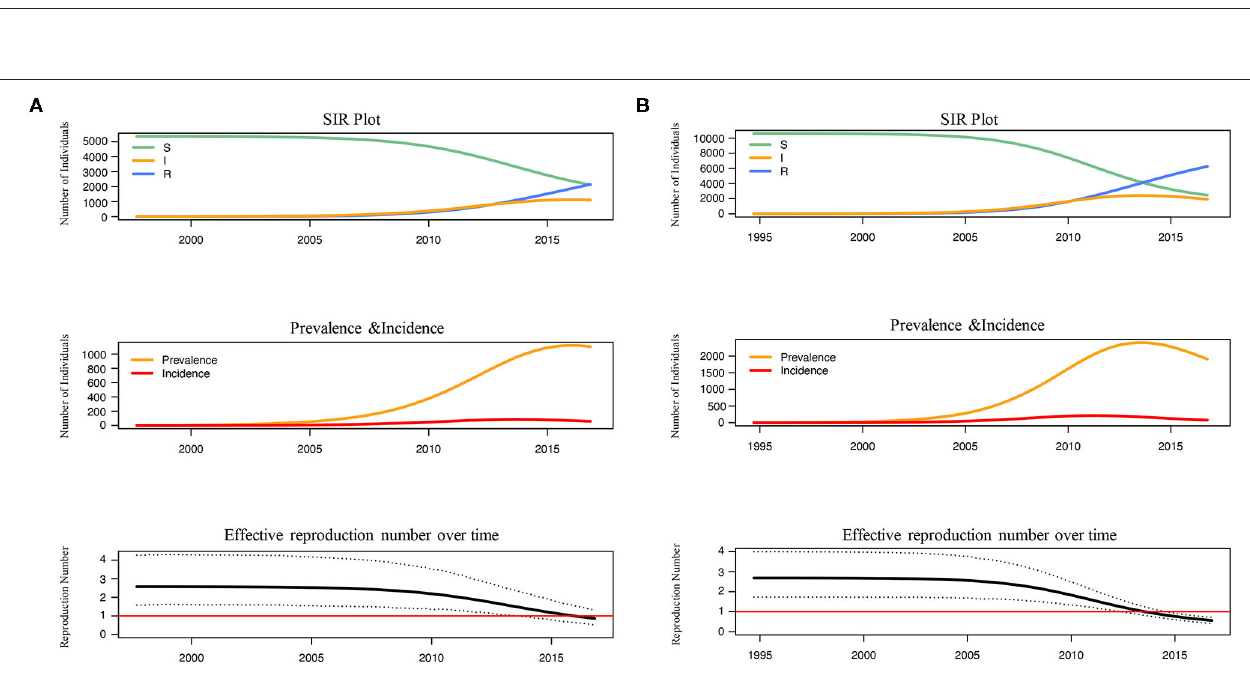
FIGURE 3 | The reconstructed SIR trajectory, incidence and effective reproduction number over time of L4 (A) and L5 (B) . The transmission dynamics of L4 and L5 in Shenyang were reconstructed using BDSIR model in BEAST v.2.6.3.The changes of susceptible-infected-recovered individuals, prevalence, incidence and effective reproduction number were